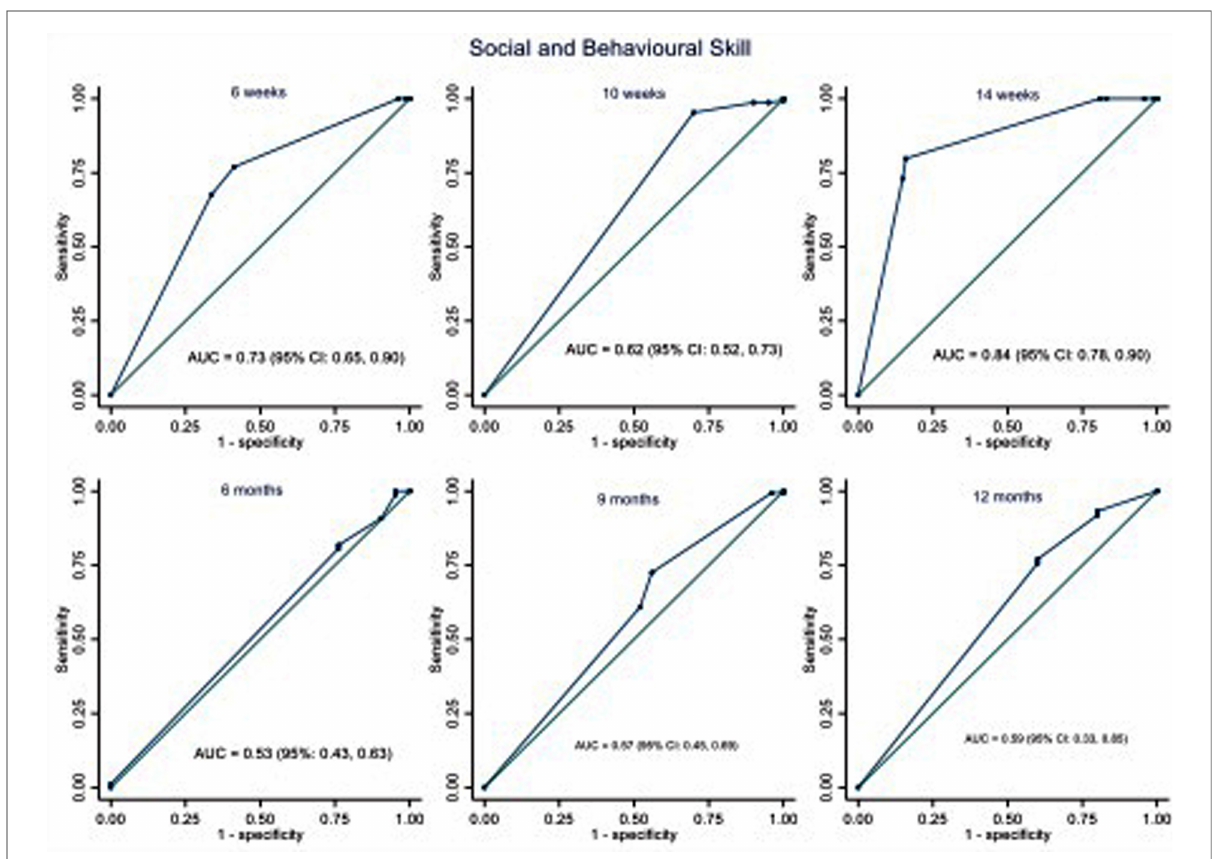
FIGURE 5 ROC curves showing the performance of ISDS in the detection of delay in social and behavioural domain at the age-speci fi c optimal